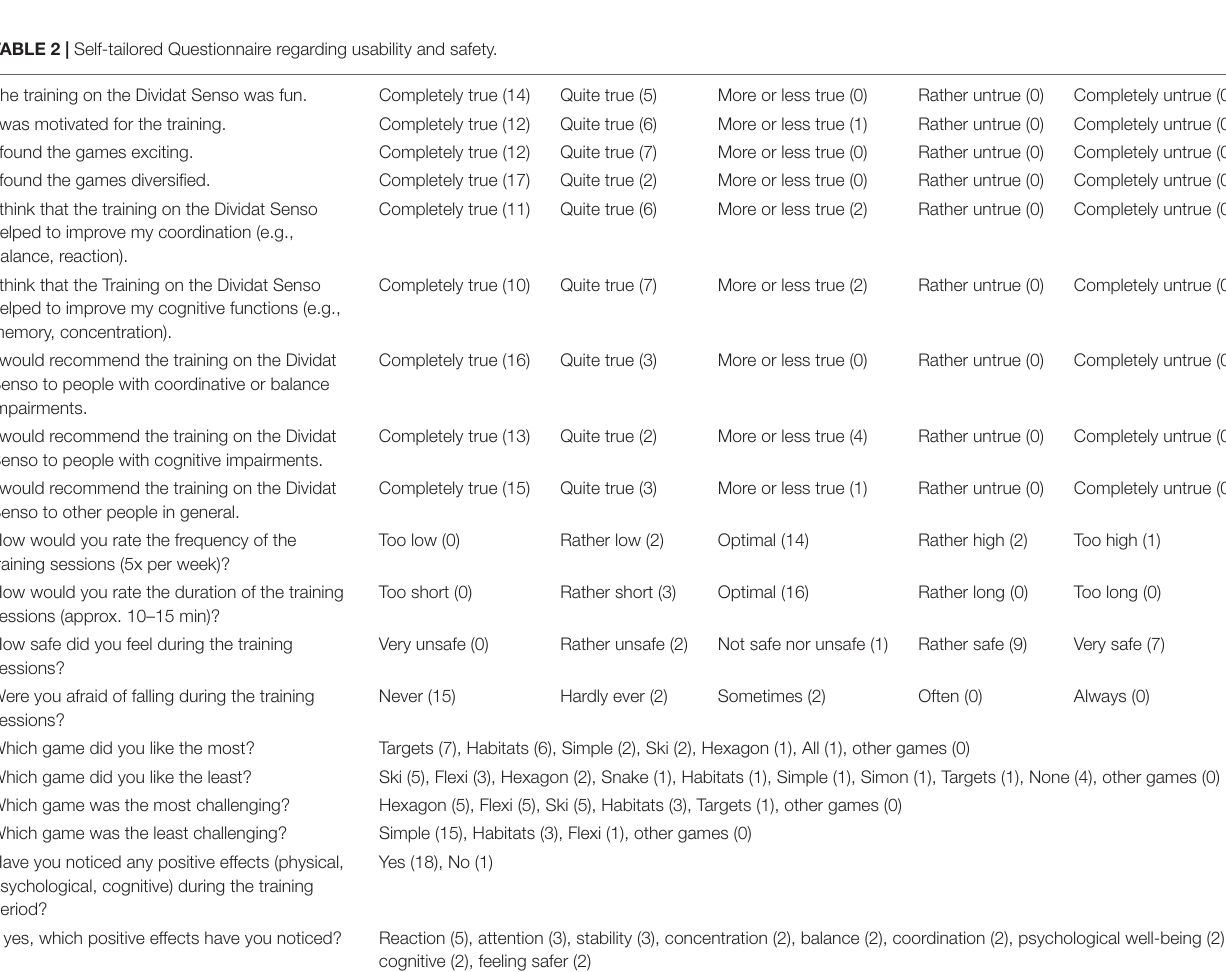
TABLE 2 | Self-tailored Questionnaire regarding usability and